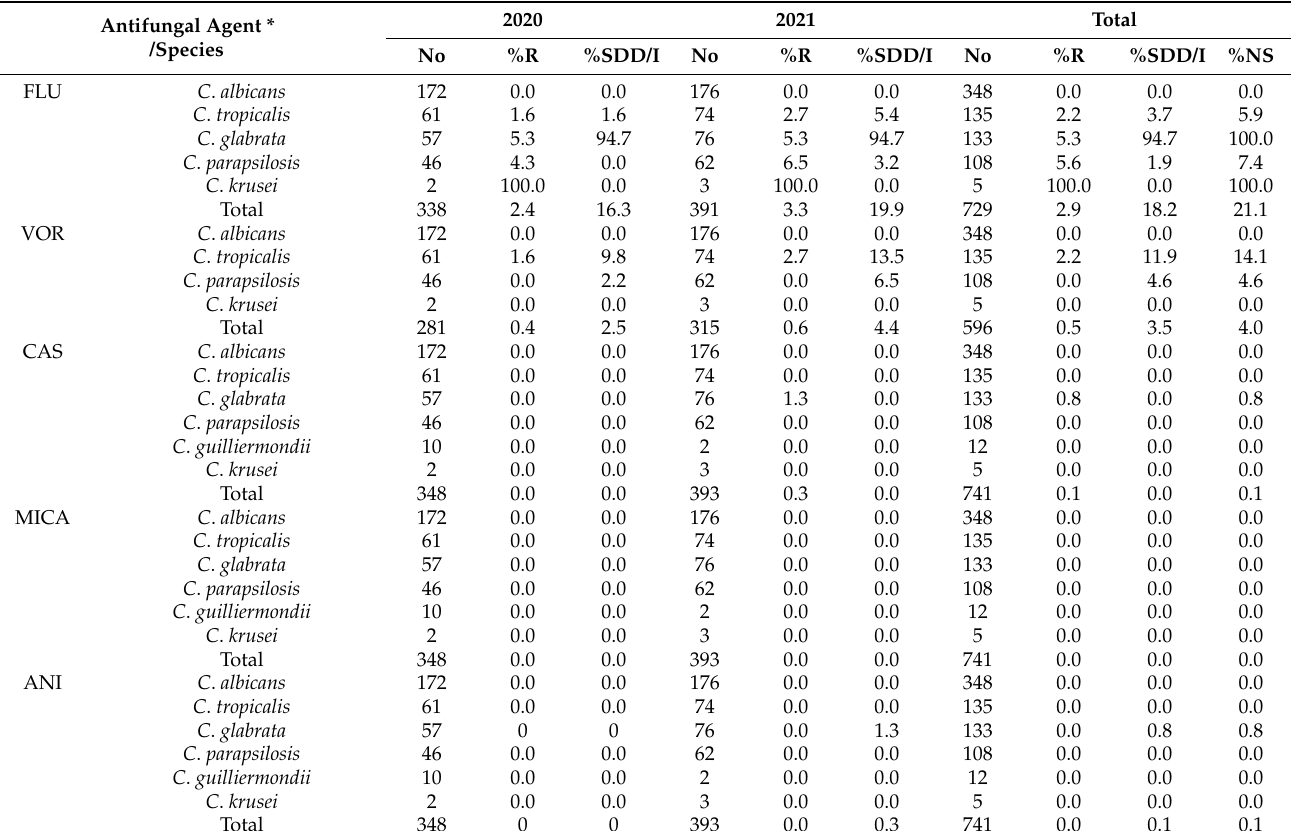
Table 2. Antifungal susceptibilities of 741 isolates of six common Candida species which clinical breakpoints are available in CLSI